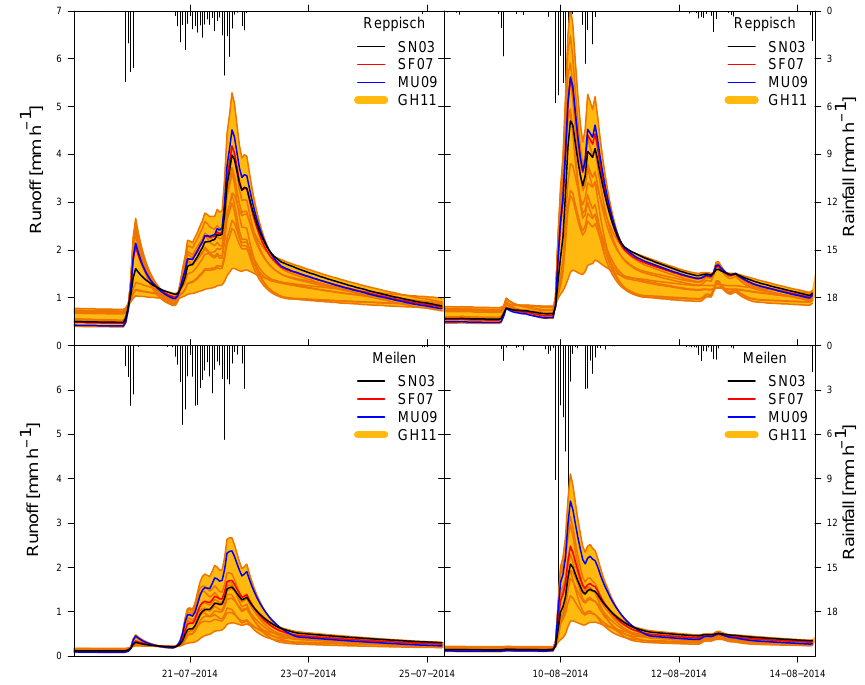
Figure 12. Simulated runoff during the two heaviest rainfall events of the simulation period, obtained from the different DRP maps for the two study sites by varying the parameter values for each RT (simulation 4.1 of Table A2). The bands represent the minimum and maximum runoff values obtained with the different parameter combinations for the simulations driven by GH11